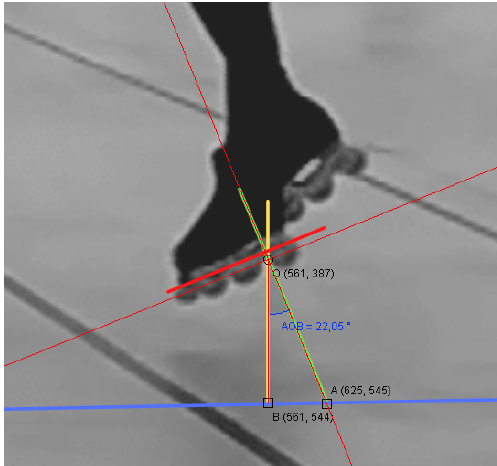
(cid:91) AOB and the distance from